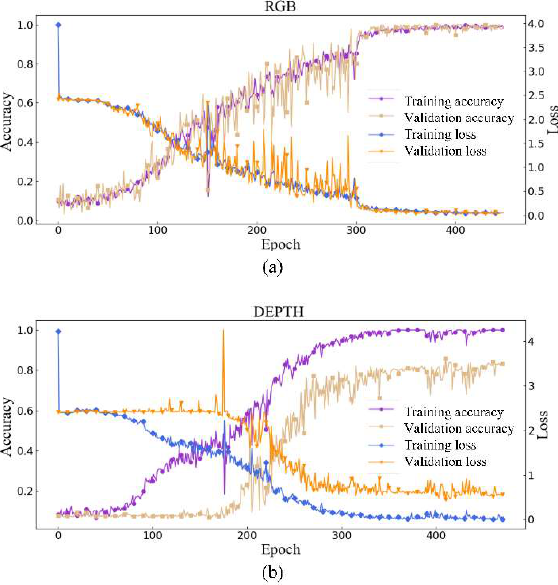
Figure 9. Training process of RGB / depth mode. ( a ) RGB mode of training process; ( b ) depth mode of training process.